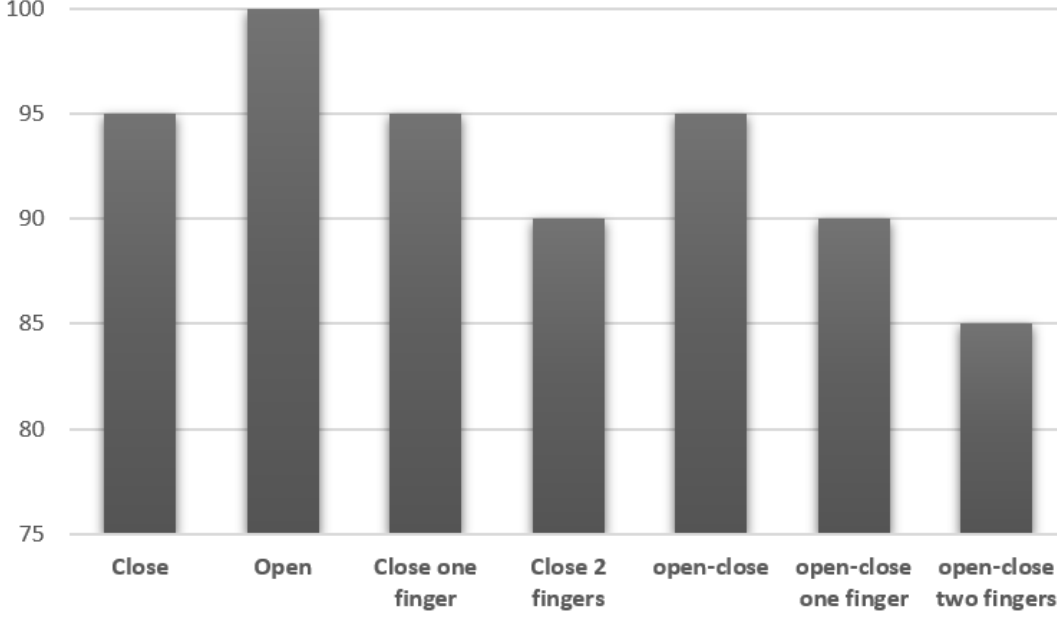
Figure 10. Success rate of hand